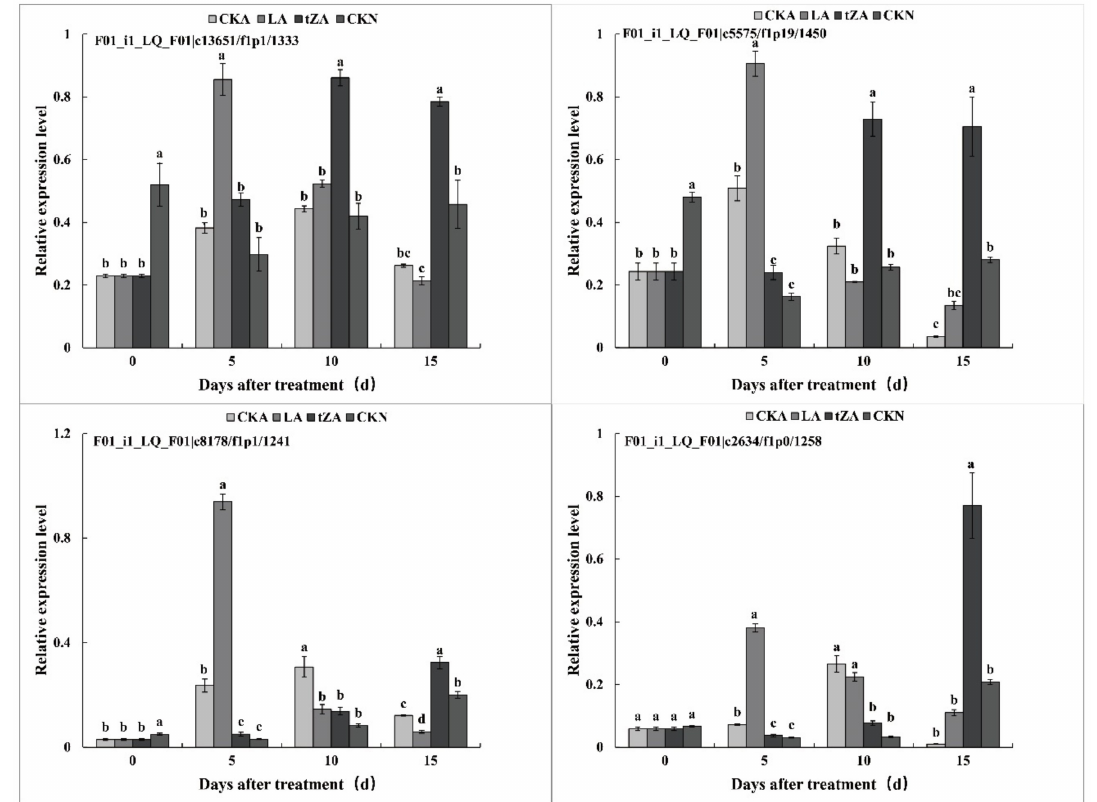
Figure 10. The relative expression level of POD related genes in CKN, CKA, tZA and LA groups after the treatment. Different lower-case letters among different treatment groups indicate significant differences based on one-way analysis of variance in SPSS 21.0 followed by the Duncan’s test ( p <